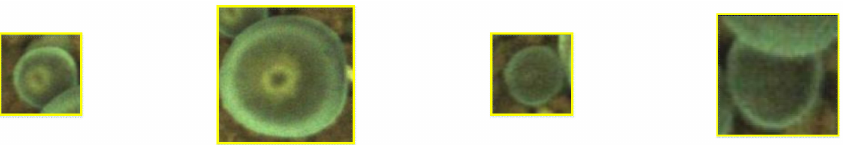
Figure 4. The results of locating different size caps by improved YOLO